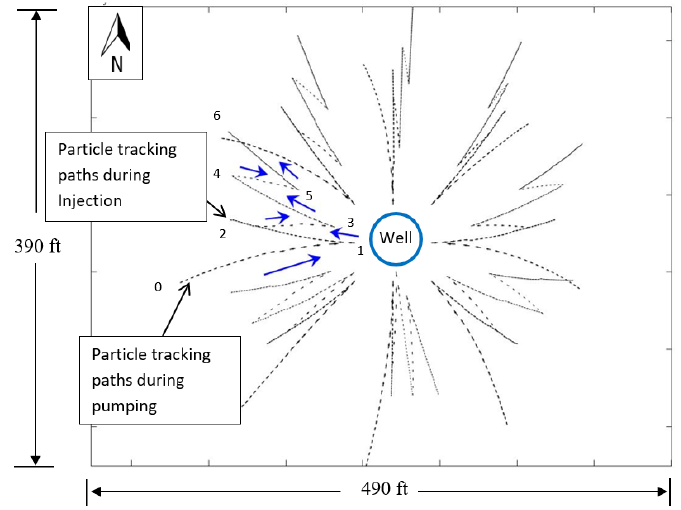
Figure 5. Movement of particles around one representative of eight wells for 130 days under continuous pumping and injection conditions at the Meadows Pumping Center, CO, USA. The blue arrows represent the particle flow directions in pumping and injection processes. The numbers are used to illustrate particle positions at the beginning or end of pumping and injection processes.